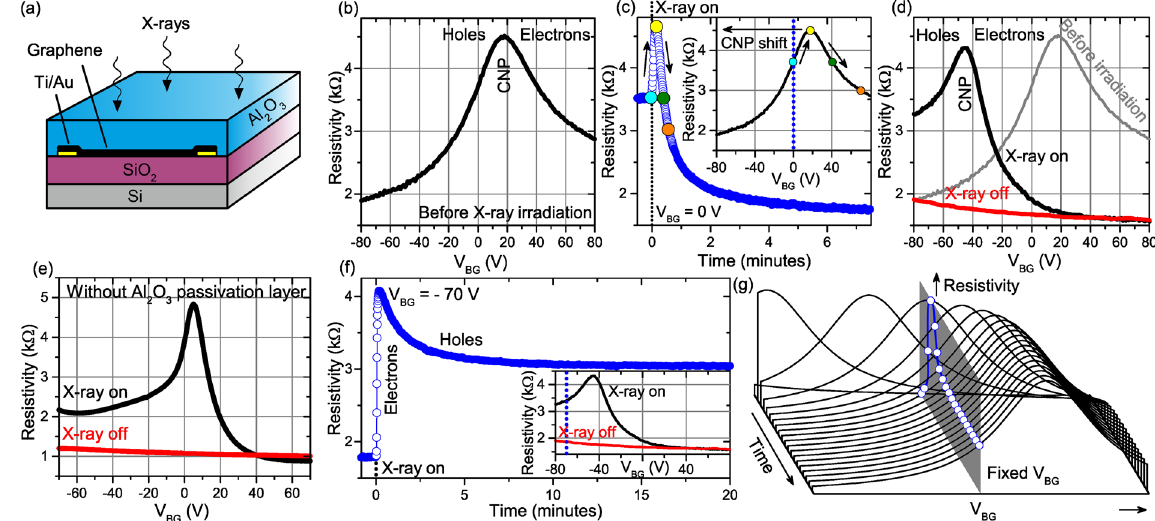
Figure 1. Evolution of GFET resistivity as a function of the back gate voltage V BG (BG trace) or time (time trace), respectively. ( a ) Schematic of the device utilized in this study. All data presented in this figure are obtained for Al 2 O 3 passivated devices except the case of the panel ( e ). The complementary data for open devices are presented in Supplementary Information, Figure S6. ( b ) BG trace measured for a pristine device (no X-ray irradiation). ( c ) Time trace recorded during the first exposure of the device at V BG = 0 V. The colored circles on the time trace mark the associated position on the BG trace portrayed in the inset. ( d ) BG traces acquired on the pristine (grey) and X-ray irradiated device while the X-ray is on (black) and off (red). ( e ) BG traces acquired for the open (non-passivated) device before (gray), during (black) and after (red) initial X-ray irradiation. ( f ) Time trace measured for V BG = − 70 V during succeeding X-ray irradiation. The inset depicts the position of V BG relatively to X-On BG trace. ( g ) Schematic illustration of formation of a time trace via a CNP shift towards more positive V BG values upon succeeding X-ray irradiation. All presented sweeps in the figure are recorded in the direction from negative to positive V BG